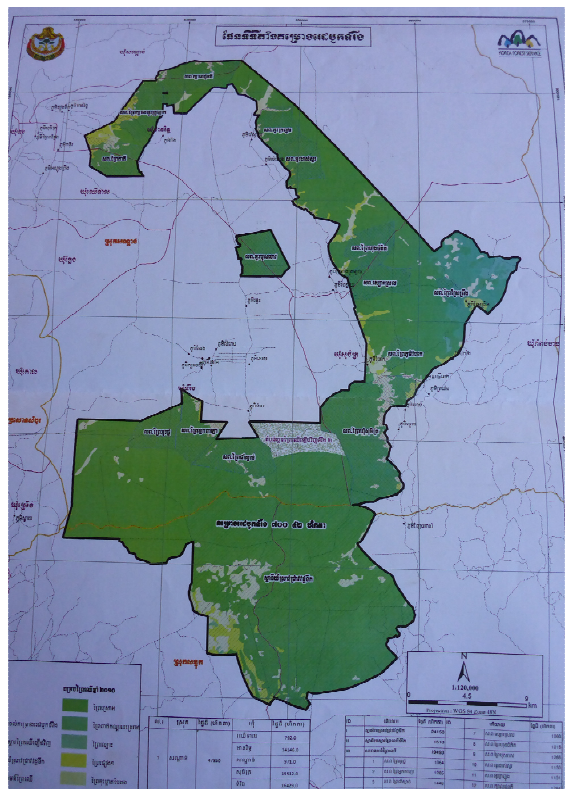
Figure 6. Photo of T-REDD Map 2 taken by